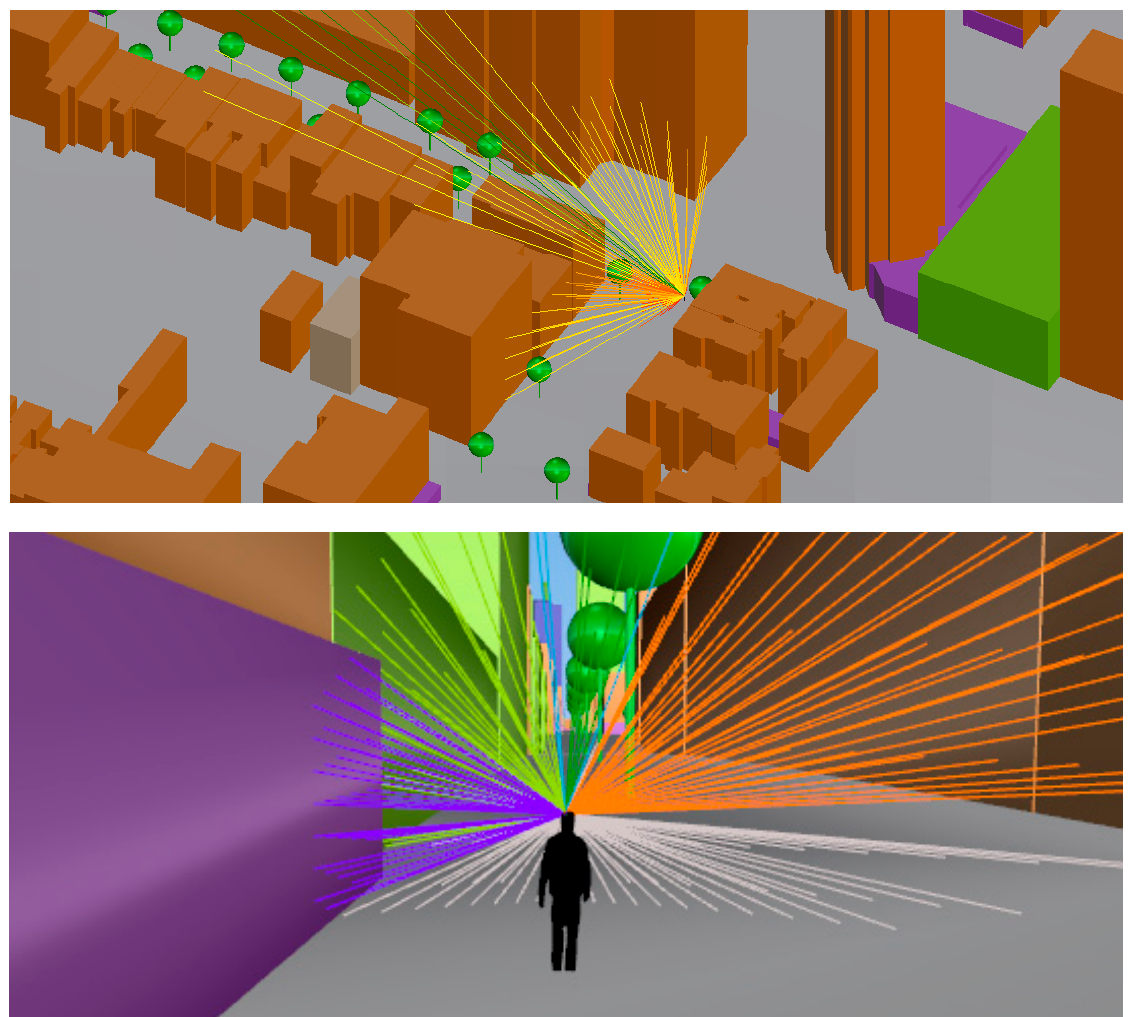
Figure 5. Simulating the visibility from a single viewpoint along the route: perspective view ( top ) and street-level view ( bottom ). LOS are depicted as straight lines in different colors according to the urban fabric element category they meet.